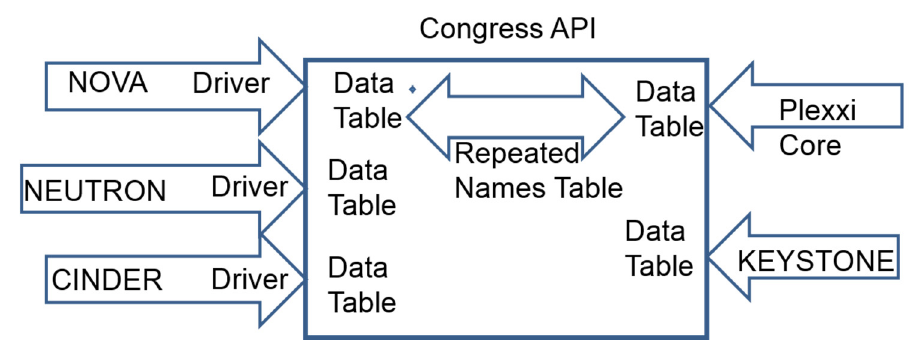
Figure 6. OpenStack Congress driver for Plexxi